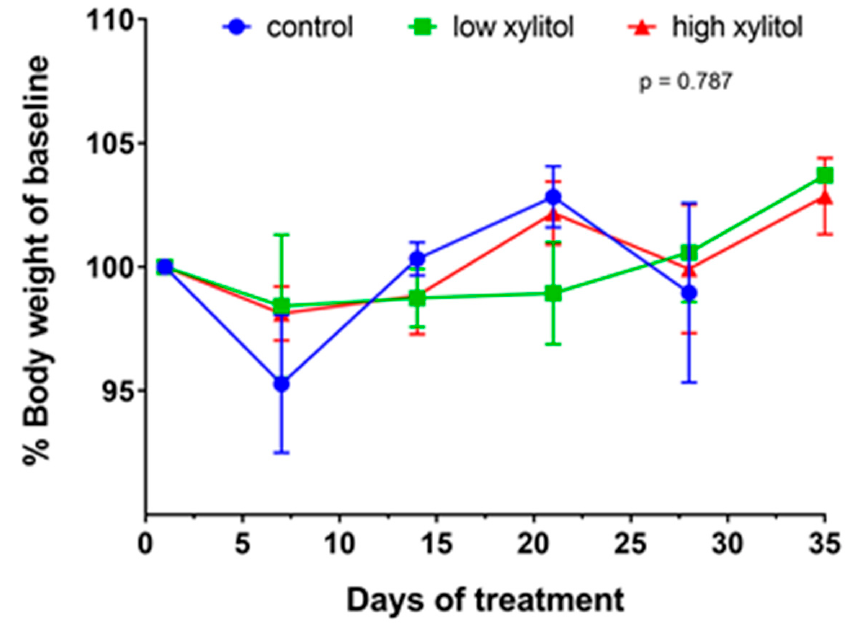
Figure 3. Changes in body weights (percent of baseline body weight) of CAL-27 xenograft-bearing mice receiving glucose solution (control), low-xylitol solution (experimental group 1), and high-xylitol solution (experimental group 2). Results are shown as mean ± SEM. p -value was obtained from a two-way ANOVA.